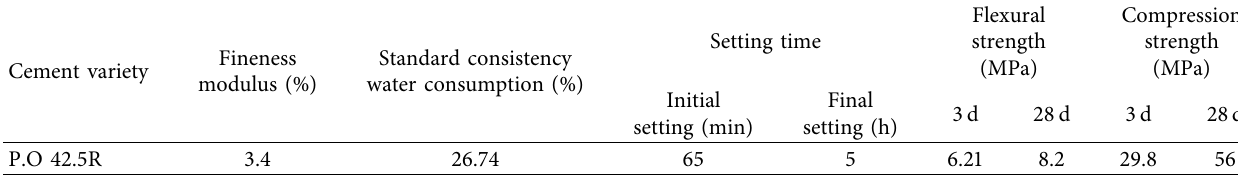
Table 1: Cement quality index.